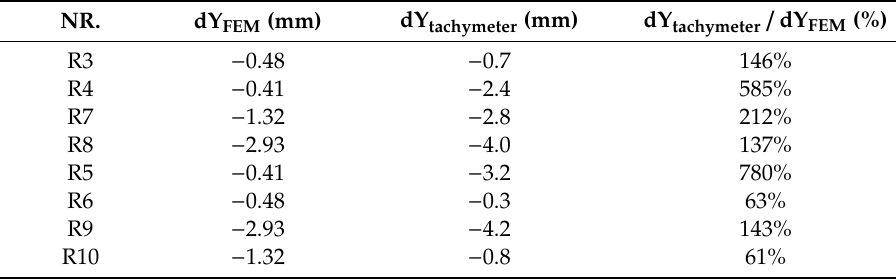
Figure 18. Comparative analysis regarding displacements at Y direction from. ( a ) Numerical model (mm); and ( b ) Laser scanning (m), top water increases from the 1/3 to the 3/3 level. (mm); and ( b ) Laser scanning (m), top water increases from the 1 / 3 to the 3 / 3 level. Table 4. Comparison of the calculated and measured Table 4. Comparison of the calculated and measured displacements.